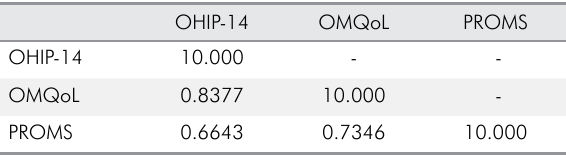
Table 3. Correlations among the OHIP-14, OMQoL and PROMS instruments*.